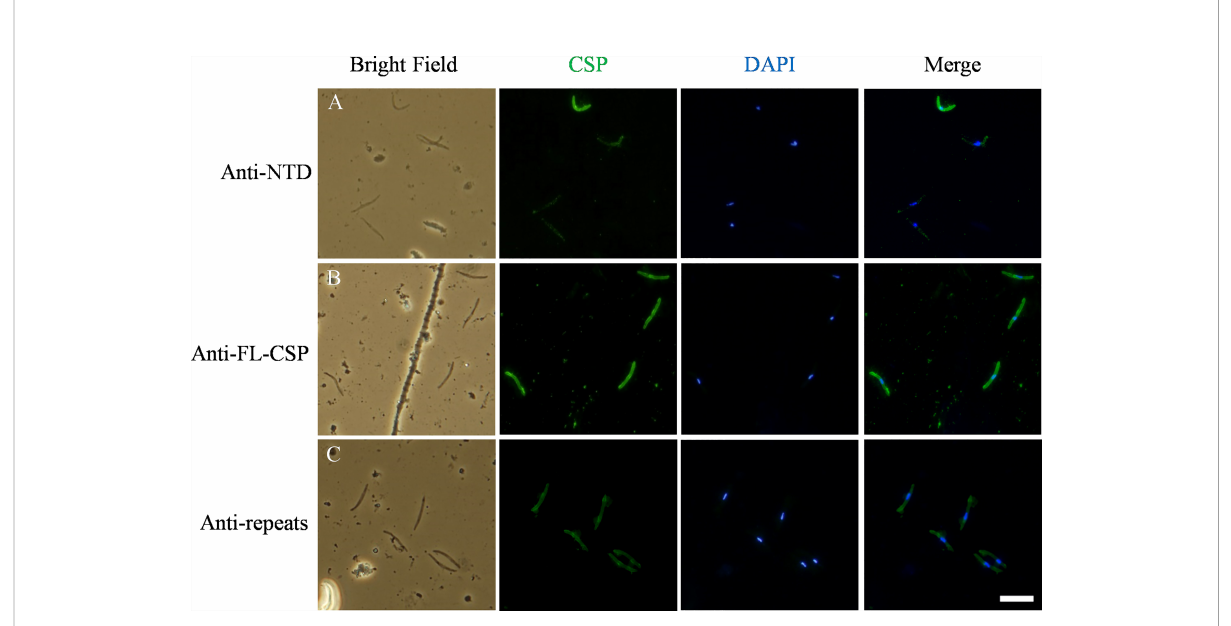
FIGURE 7 Variable quantities of NTD of CSP are displayed on the surface of SPZs in the in-vitro assays. CSP (green) displayed on the surface of SPZs was stained with antibodies generated against: (A) the NTD, (B) the full length CSP (FL-CSP) and (C) the CSP repeats. Nuclei were stained with by DAPI (blue). Scale bar, 10